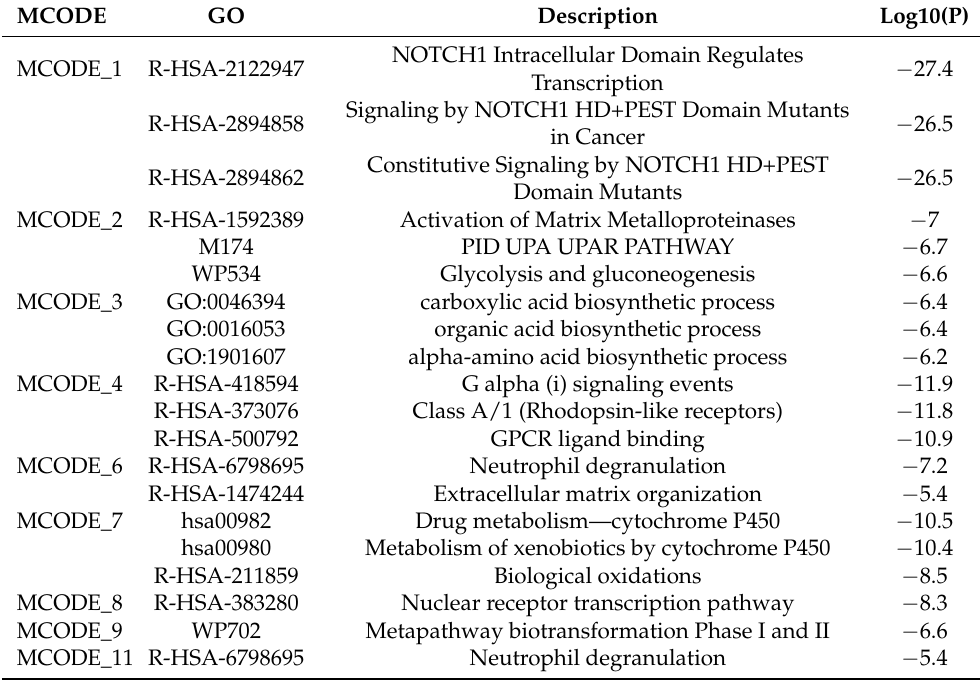
Table 2. MCODE components identified in p-CA target